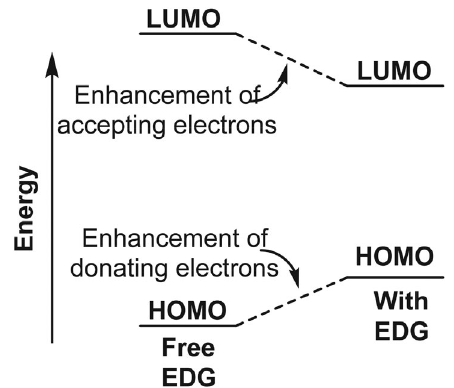
Figure 1. HOMO and LUMO energy